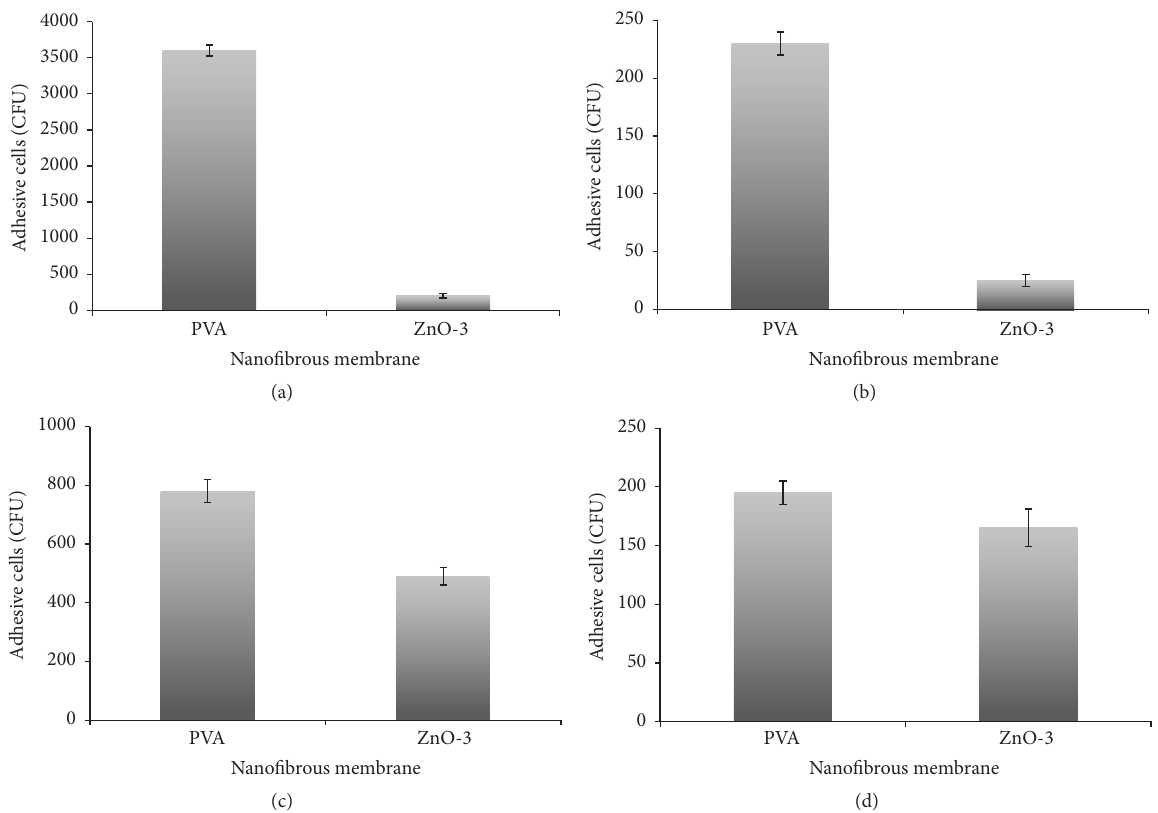
Figure 7: Cell adhesion tests of S. aureus (a), E. coli (b), C. albicans (c), and A. niger (d).